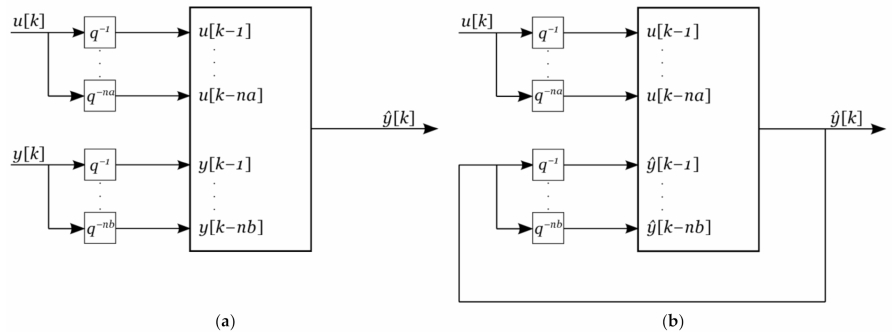
Figure 3. Model structure: ( a ) equation error model; ( b ) output error